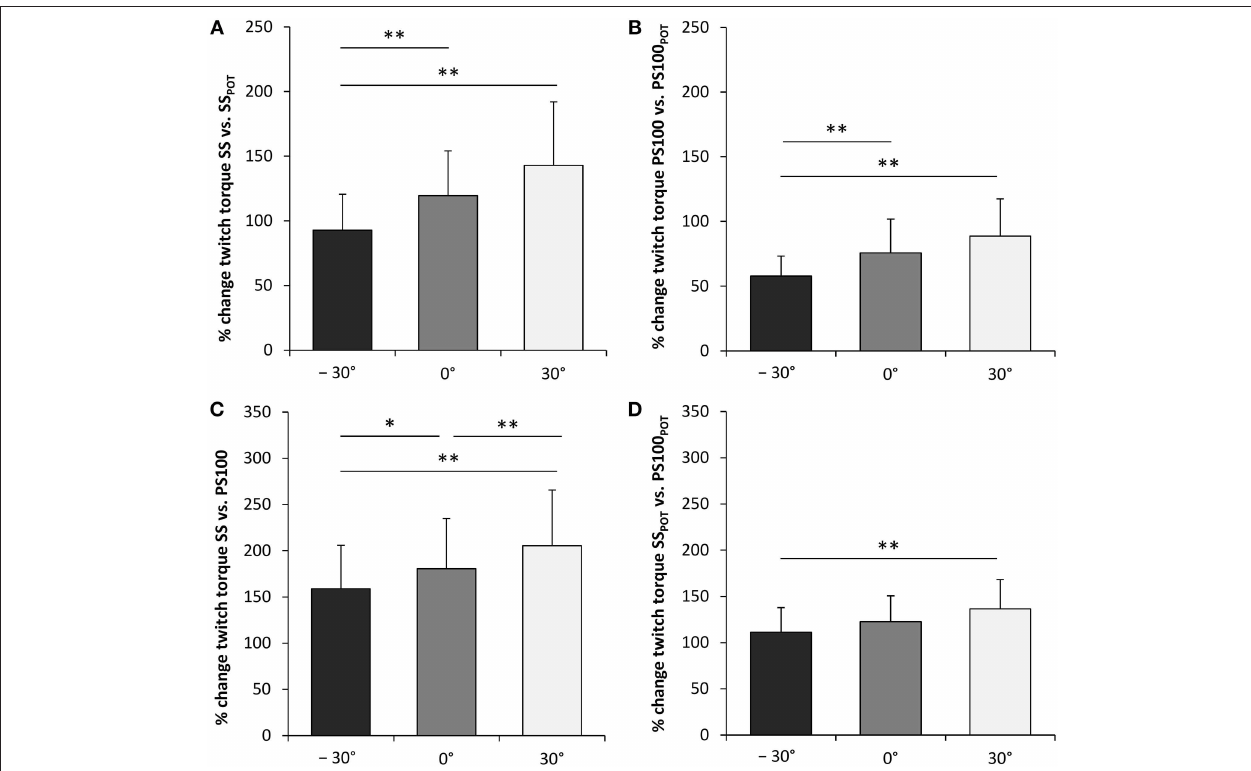
FIGURE 5 | Activity-induced potentiation (%) of peak twitch torques evoked by single (A) and paired electrical stimuli (B) . Percentage contribution of a second electrical stimulus to the unpotentiated (C) and the potentiated peak twitch torque production (D) . SS, unpotentiated peak twitch torque evoked by a single stimulus; PS100, unpotentiated peak twitch torque evoked by paired stimuli at 100Hz [inter-stimulus interval (ISI) 10ms]; SS POT , potentiated peak twitch torque evoked by a single stimulus; PS100 POT , potentiated peak twitch torque evoked by paired stimuli at 100Hz (ISI 10ms); − 30 ◦ , extension: long wrist flexor muscle length; 0 ◦ , neutral: intermediate wrist flexor muscle length; 30 ◦ , flexion: short wrist flexor muscle length. *Denotes a significant difference between joint angles (* P ≤ 0.050, ** P ≤ 0.010). Values are expressed as means ± standard